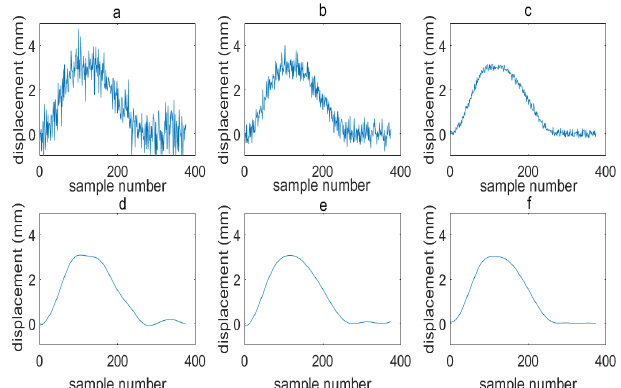
Figure 6: Gauss distributed noisy signals (a, b, c) and their denoised forms (d, e,